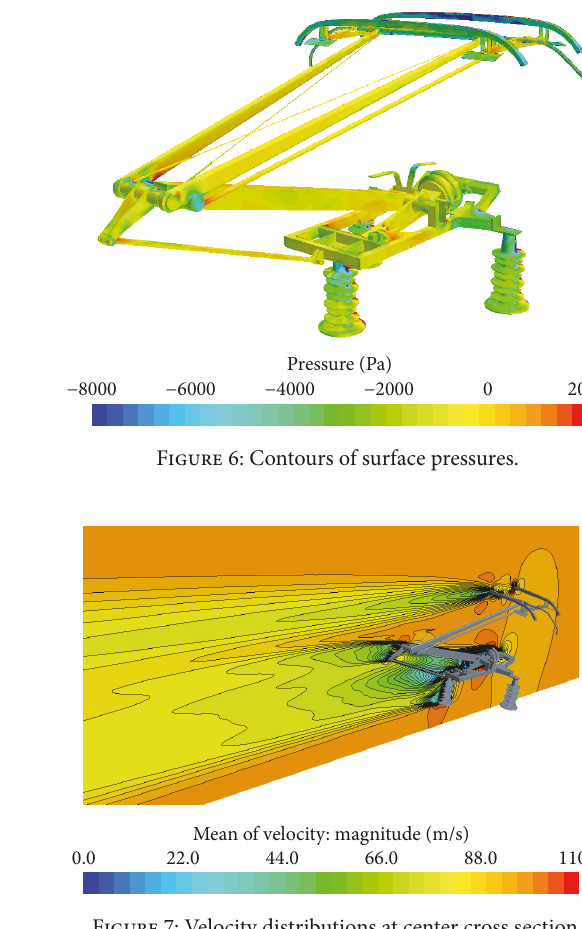
Figure 7: Velocity distributions at center cross